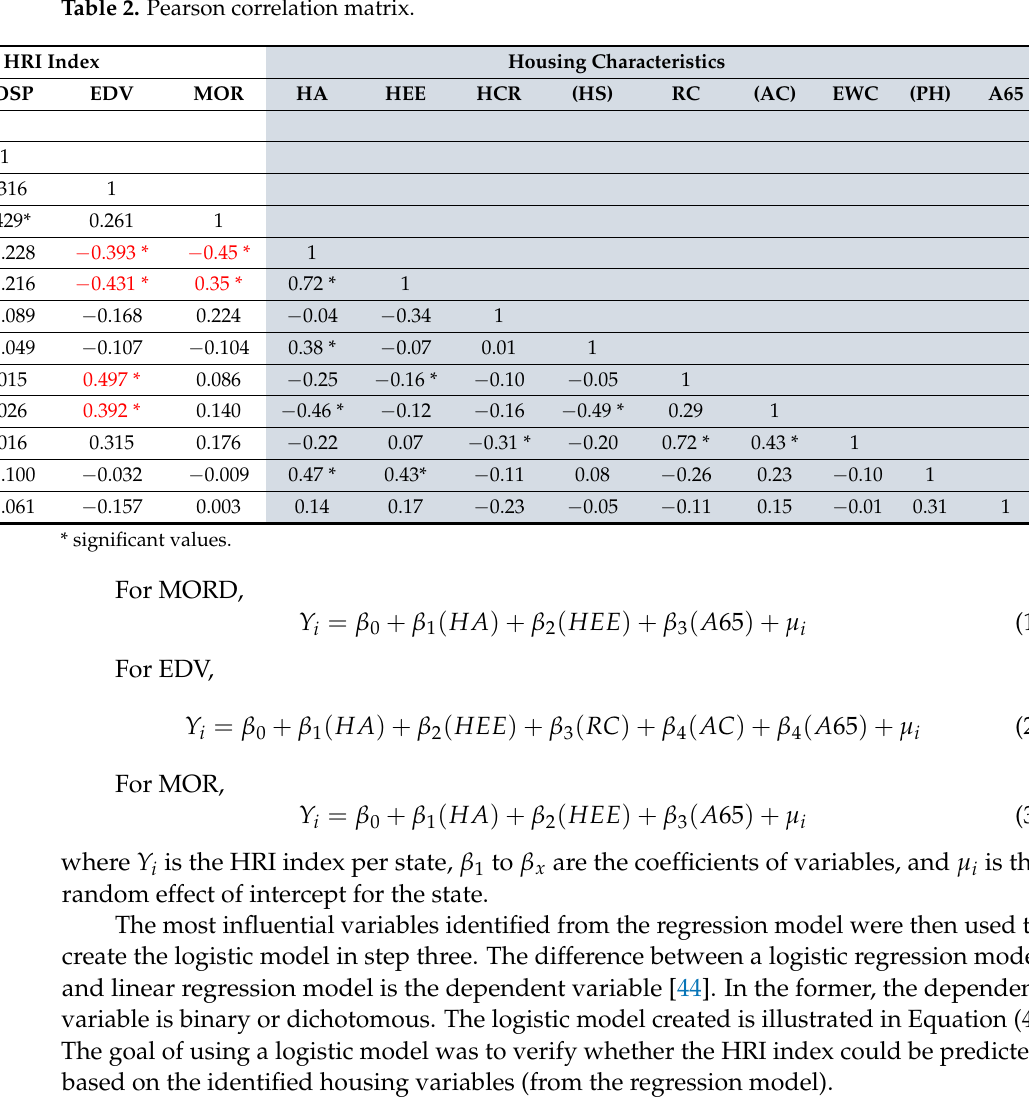
Table 2. Pearson correlation